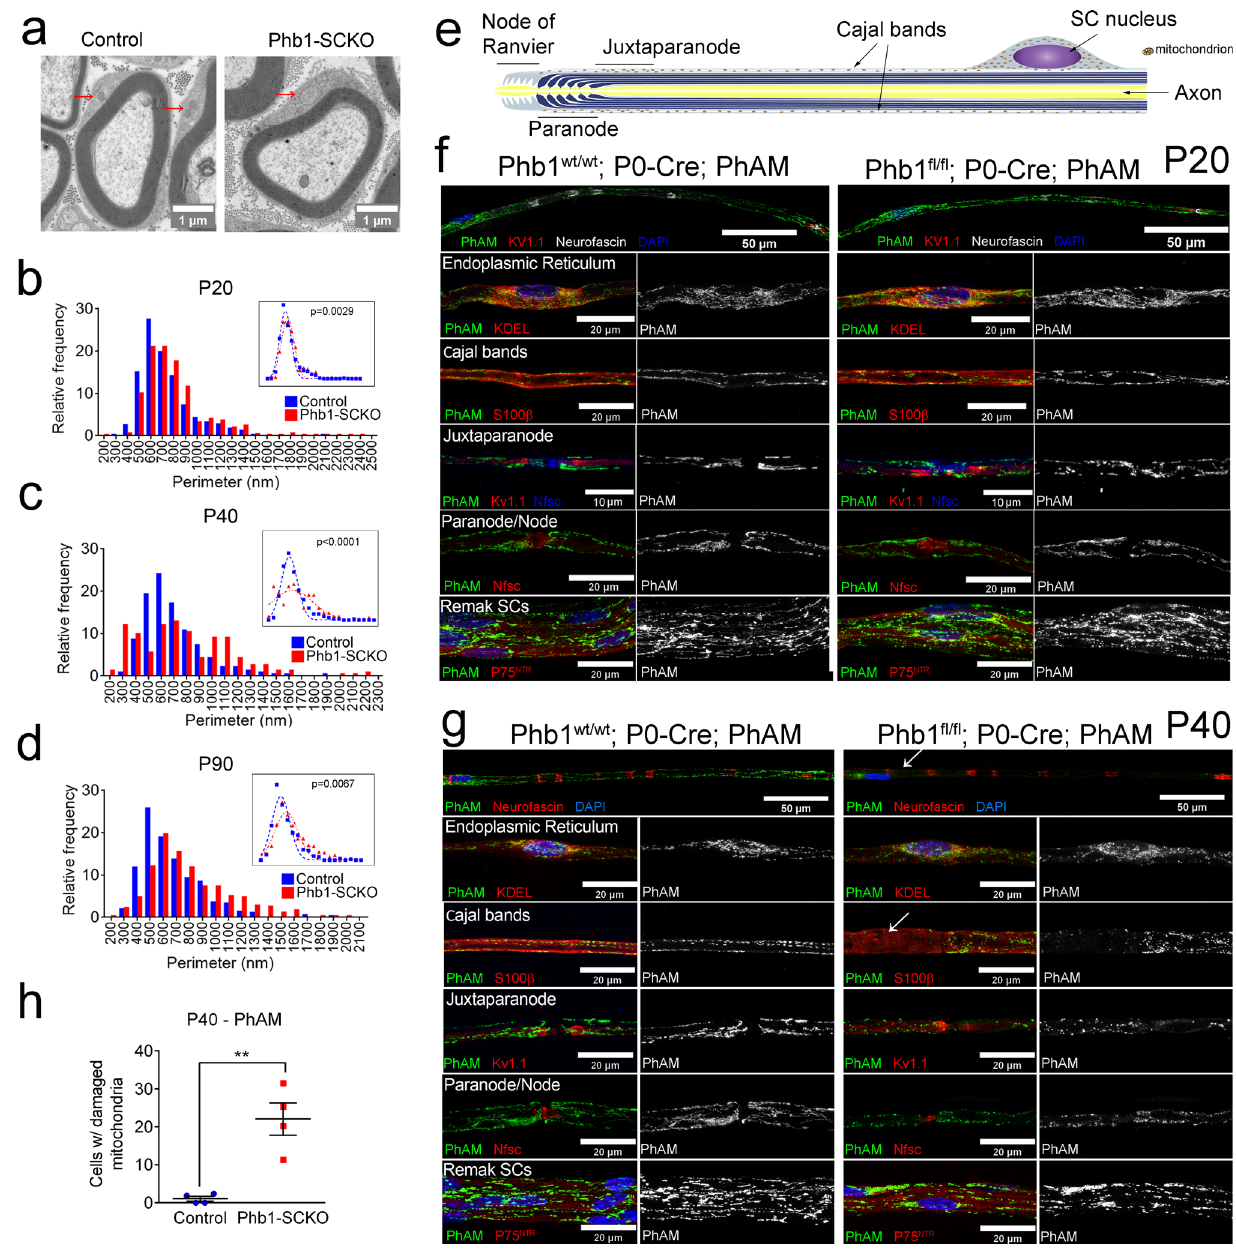
Fig. 3 Ablation of Prohibitin 1 in Schwann cells results in altered mitochondrial morphology. a Representative electron micrographs highlighting the enlargement of mitochondria in sciatic nerves of Phb1-SCKO animals at postnatal day 20 (P20) (arrows). N = 3 animals per genotype. ( b - d ) Mitochondria in SCs of PHB1-SCKO mice (red) have a larger perimeter compared to mitochondria of control animals (blue) at P20 ( b ), P40 ( c ), and P90 ( d ). At P40, there is also a population of mitochondria that has a reduced perimeter, suggesting mitochondrial fragmentation. This population is lost at P90, suggesting that the fragmented mitochondria disappear. N = 3 animals per genotype; at least 100 mitochondria from each animal were evaluated. Insets: non-linear regression using a Gaussian curve followed by extra sum-of-squares F test [ F (3,42) P20 = 5.482, F (3,38) P40 = 19.48, F (3,34) P90 = 4.813). e Schematic representation of the distribution of mitochondria in a myelinating SC. f – g Confocal z-projections of teased fi bers of sciatic nerves of Phb1-SCKO mice and controls illustrating the morphology of Schwann cell mitochondria as labeled by the PhAM reporter (green) near different cellular structures (red). DAPI is indicated in blue. f At P20, there are changes in mitochondrial size. N = 4 animals per genotype. g At P40, some cells lack PhAM expression away from the cell body. N = 3 animals per genotype. h PhAM is not detectable in about 20% of the myelin internodes of Phb1-SCKO animals at P40. N = 4 animals per genotype. Unpaired two-tailed t -test ( t = 4.866, df = 6, p = 0.0028). Data are presented as mean ± SEM. ** p < transcriptional regulators essential for mitochondrial physiology (Supplementary Fig. 10). SCKO animals (Fig. 4a) and consequent reduction in levels of transcripts encoded from the mtDNA at P40 in the same tissue (Supplementary Fig. 10). In addition, sciatic nerves of P40 Phb1- SCKO mice showed a reduction in mRNA levels of Tfam and a trend toward reduction of PGC1 α , two genomically encoded